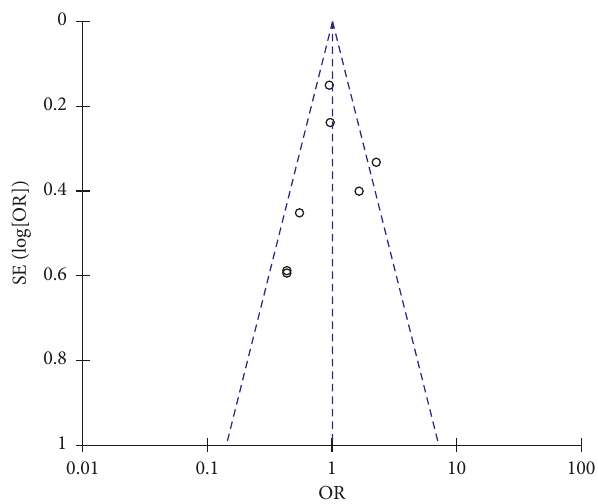
Figure 3: Funnel plot for assessment of publication bias for freedom from atrial fibrillation at 12-month follow-up.